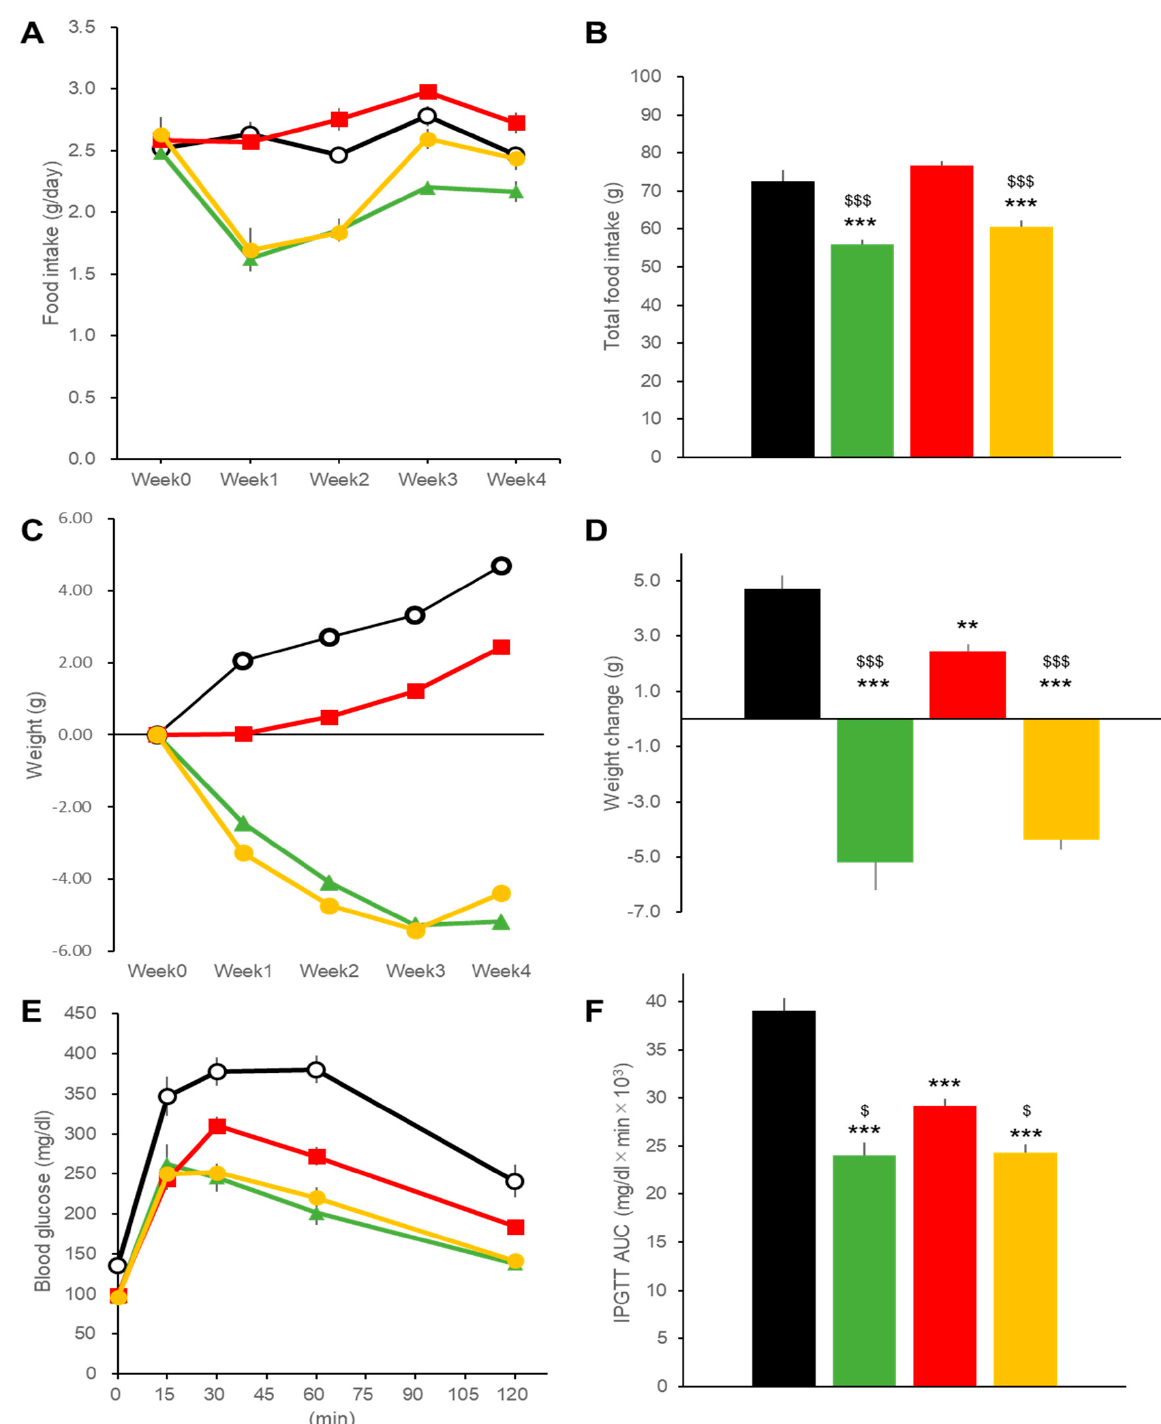
Figure 1. Effects of treatments with liraglutide and/or ipragliflozin on food intakes, body weight, and glycemic control in DIO mice. Time course ( A ) and total amounts ( B ) of food intake in vehicle-treated DIO mice (black line and bar) and in mice treated with liraglutide (green), ipragliflozin (red), and the combination regimen (orange). Time courses ( C ) and final changes ( D ) of body weight in mice treated with liraglutide and/or ipragliflozin. Blood glucose excursions during intraperitoneal glucose tolerance tests ( E ) and AUC ( F ) calculated from €. Data represent mean ± SE, n = 6 DIO mice for four different treatments. ** p < 0.01, *** p < 0.001 vs. Control; $ p < 0.05, $$$ p < 0.001 vs. IPRA group. Week0 was 16 weeks of age.